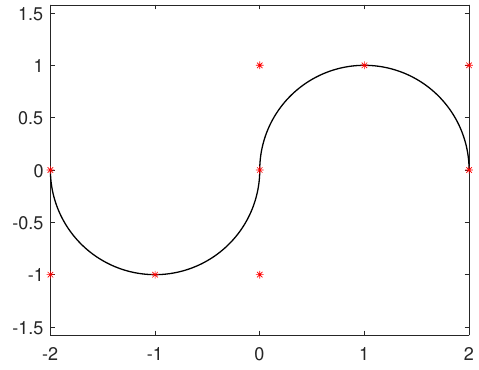
Figure 22. S-shaped obstacle of the last numerical example.